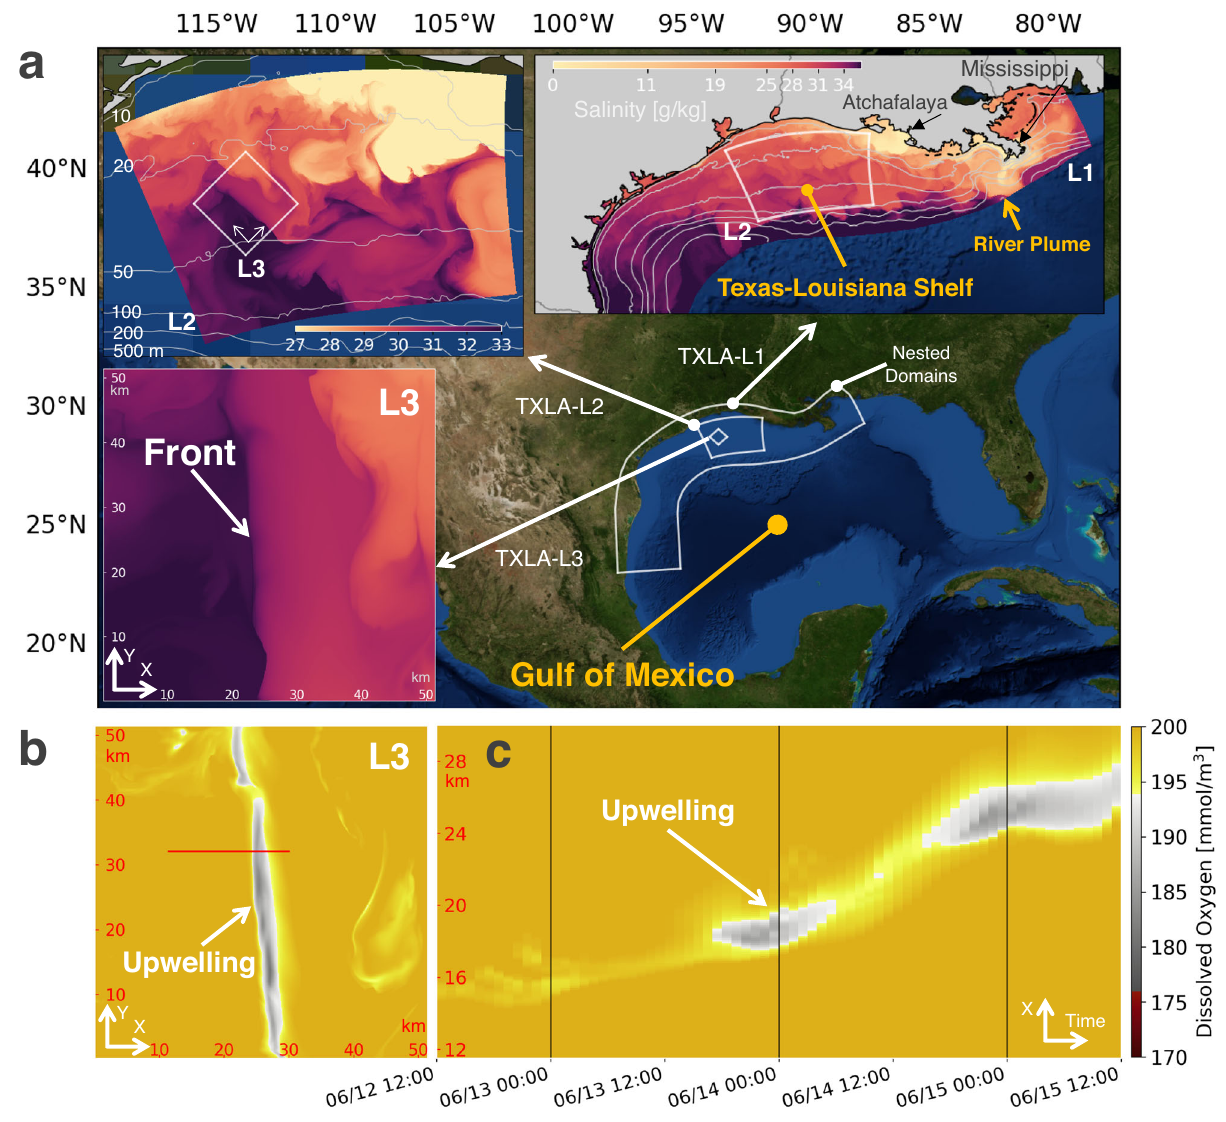
Fig. 1 | Map of study site and triple-nested simulations. a Northern Gulf of Mexico, Texas-Louisiana Shelf, and surface salinity from simulations. In sum- mertime, the Mississippi and Atchafalaya rivers create a large river plume over the shelf with buoyant, relatively fresh water. Simulations termed TXLA (Texas- Louisiana) are triple-nested (see Methods for details). L1, L2, and L3 represent the nested layers. A front characterized by strong salinity gradients is high- lighted in the L3 subpanel. Isobaths are contoured in gray in the L2 subpanel. b Horizontal slice of the dissolved oxygen at z= − 4.7m from the L3 simulation.